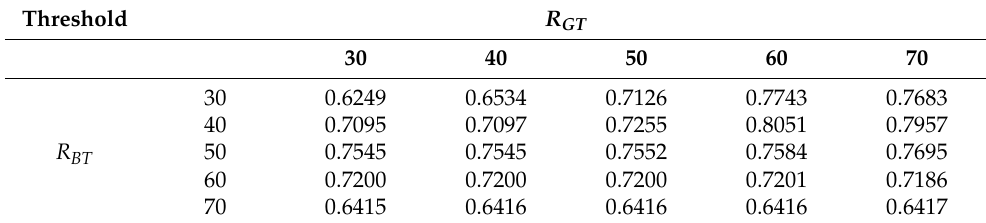
Table 1. Extraction accuracy of RGB color space with different values.